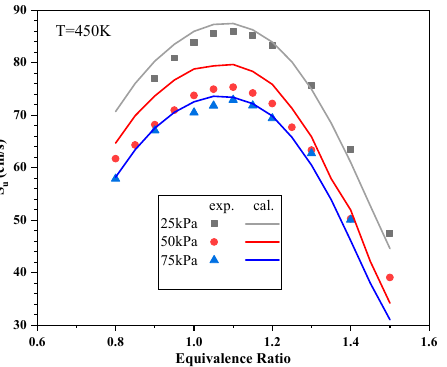
Figure 10. Comparison of 𝑆 (cid:3048)(cid:2868) between the simulation and experimental results. As shown in Figure 11, the chain branching reaction R226 (H + O 2 → O + OH) was found to be dominant at all the initial pressure conditions. As the initial pressure de- creased, the sensitivity coefficient of this reaction gradually decreased. In addition, the sensitivity coefficients of the chain termination reactions R275 and R233 decreased with decreases in the initial pressure, and the relative changes in these coefficients were much greater than those of reaction R226. Figure 12 summarizes the changes in normalized sen- sitivity coefficients, ∆S (cid:3036) = (cid:3435)𝑆 (cid:3036) − 𝑆 (cid:3036),(cid:2868) (cid:3439)/𝑆 (cid:3036),(cid:2868) , where 𝑆 (cid:3036) is the sensitivity coefficient of the 𝑖 (cid:3047)(cid:3035) reaction and 𝑆 (cid:3036),(cid:2868) is the sensitivity coefficient of the 𝑖 (cid:3047)(cid:3035) reaction at an initial pressure of 100 kPa. These results show that decreases in pressure reduced the sensitivity coefficients of the majority of these reactions, which in turn limited the effects of such reactions on 𝑆 (cid:3048)(cid:2868) .